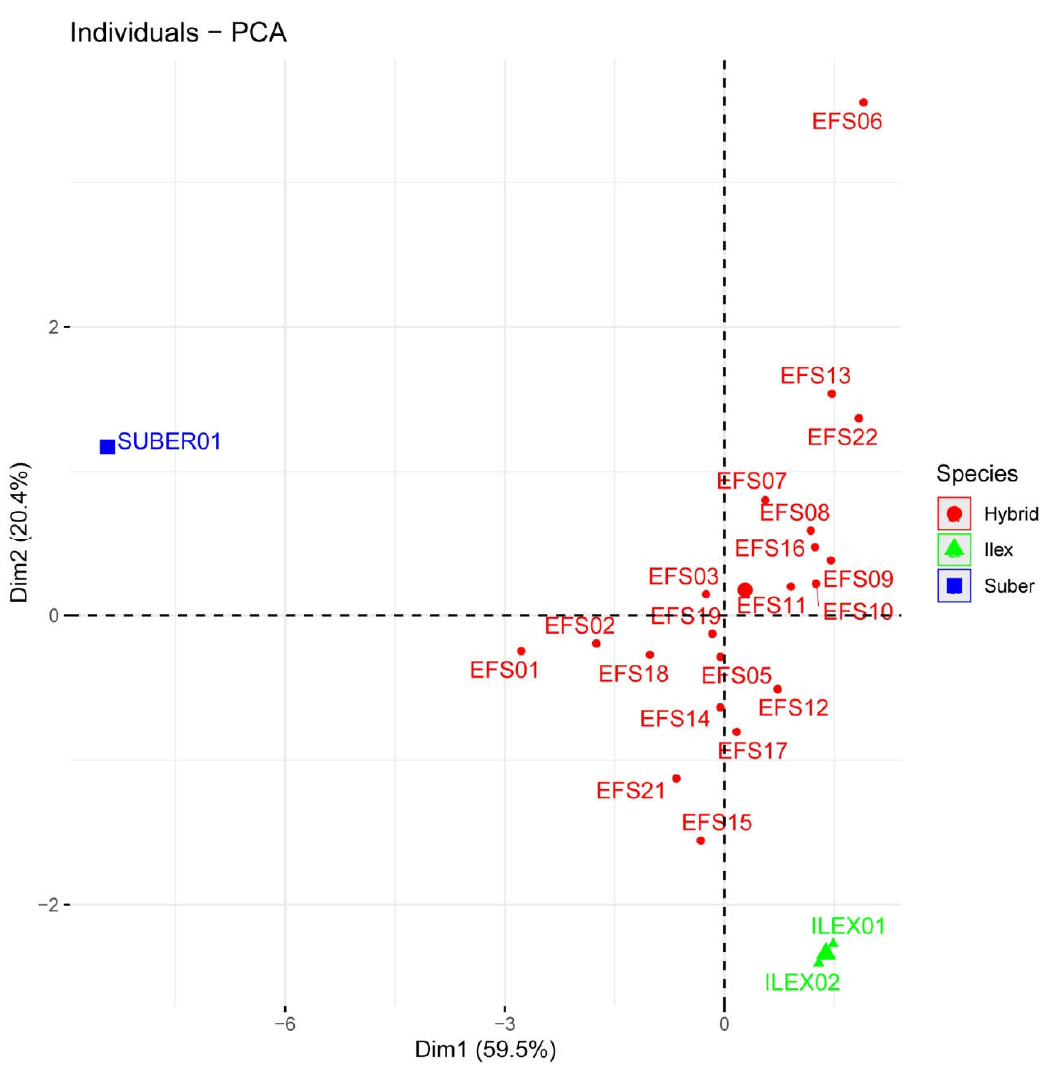
Figure 5. Biplot of the mean individual scores for the first two PCs for the multivariate analysis. The percentage of variance explained by each principal component is indicated.